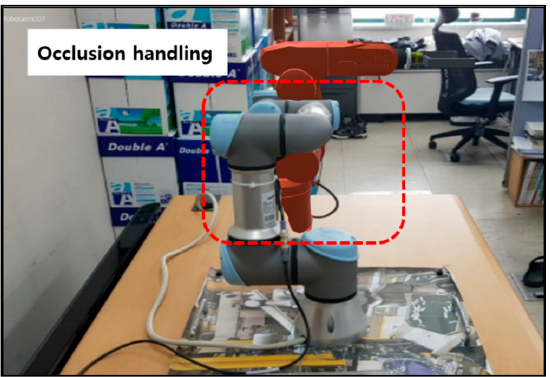
Figure 9. Handling of incorrect occlusion in Figure 1b using 3D spatial relation